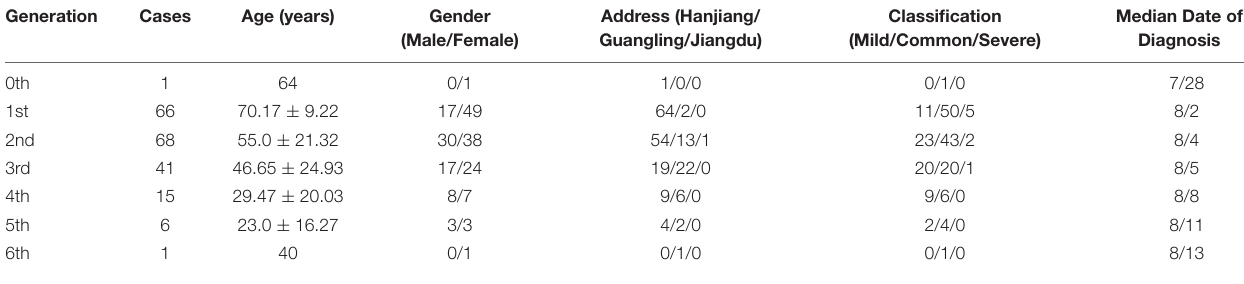
TABLE 2 | Basic information of communication chain formed by six generations of confirmed patients.